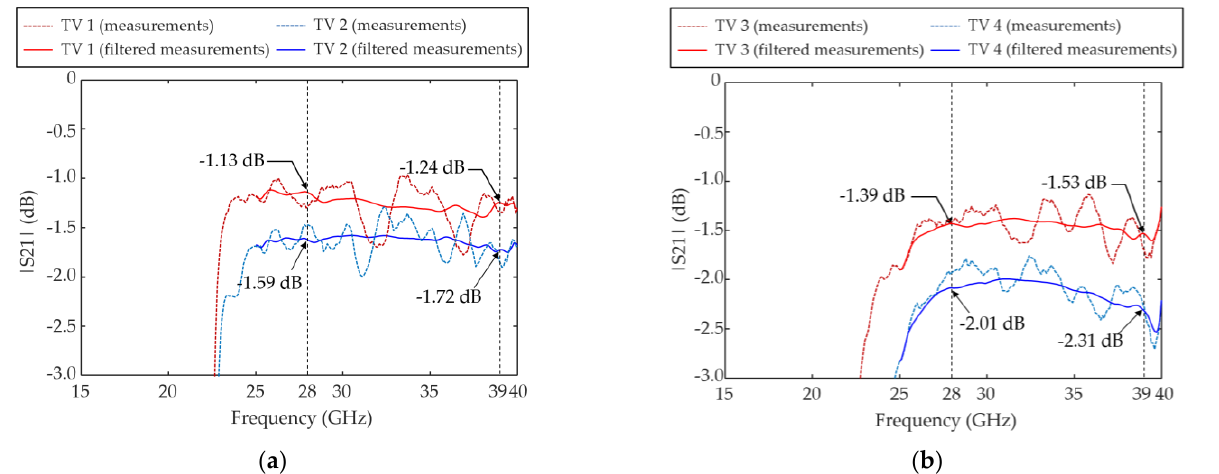
Figure 8. S 21 measurements of ( a ) TV 1 and TV 2 and ( b ) TV 3 and TV 4 for per-unit-length charac- terization using difference length method.